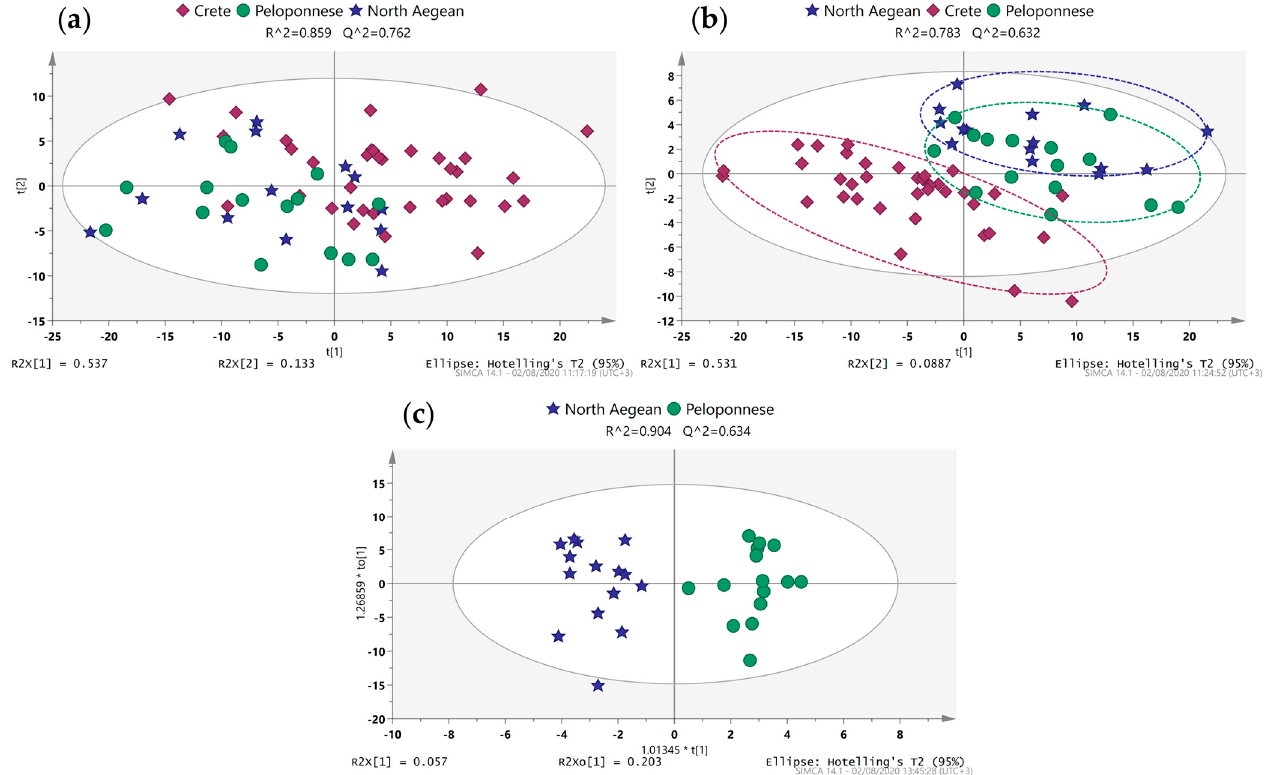
Figure 2. ( a ) Unsupervised PCA scores scatter plot of PC1 and PC2 with the Greek samples examining geographical origin; ( b ) respective supervised PLS-DA scores scatter plot; ( c ) OPLS-DA scores scatter plot with samples from the North Aegean vs. Peloponnese.